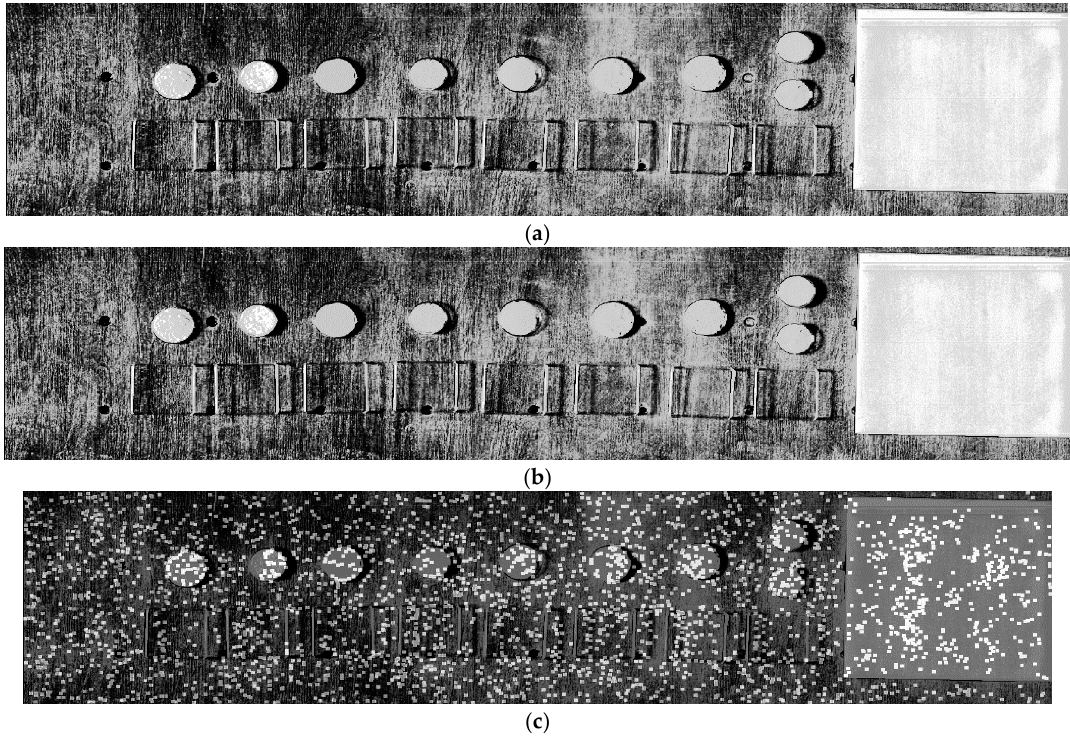
Figure 6. ( a ) Grey scaled VNIR band 153, ( b ) grey scaled SWIR band 1 and ( c ) VNIR band 153 as shown in (a), overlain by those tie points, highlighted in white, which have been found with SIFT between (a) and (b).